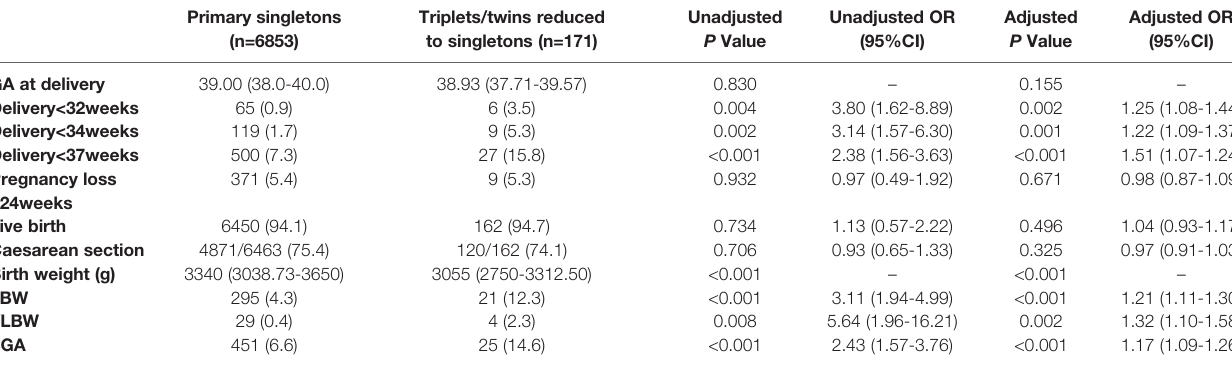
TABLE 5 | Pregnancy outcomes of triplets or twins reduced to singletons versus primary singletons. Primary singletons Triplets/twins reduced (n=6853) to singletons